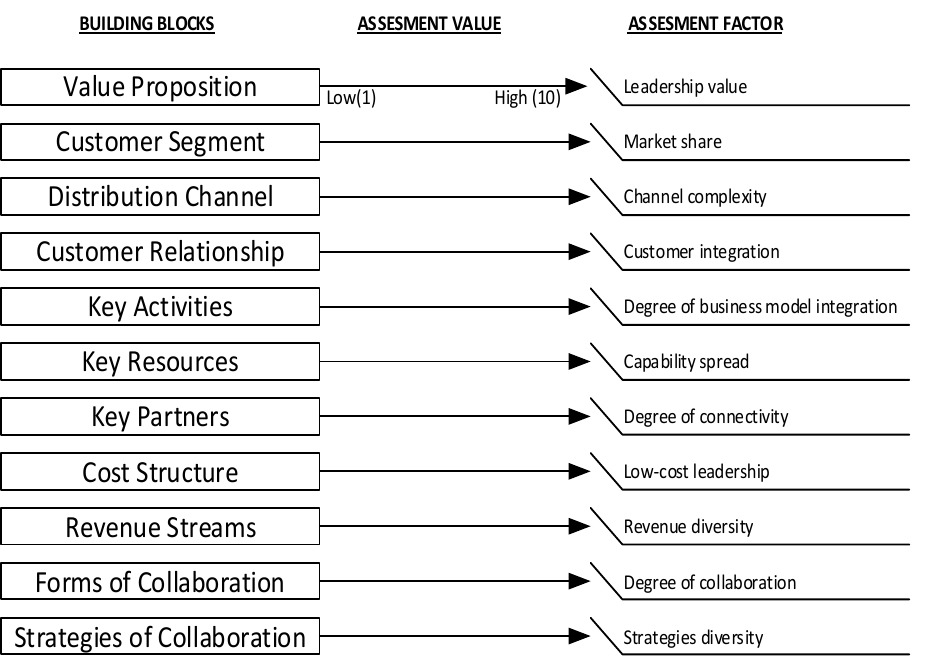
Figure 7 . Assessment factor categorization per building block . Source: Adapt from [70]. Figure 7. Assessment factor categorization per building block. Source: Adapt from [70].